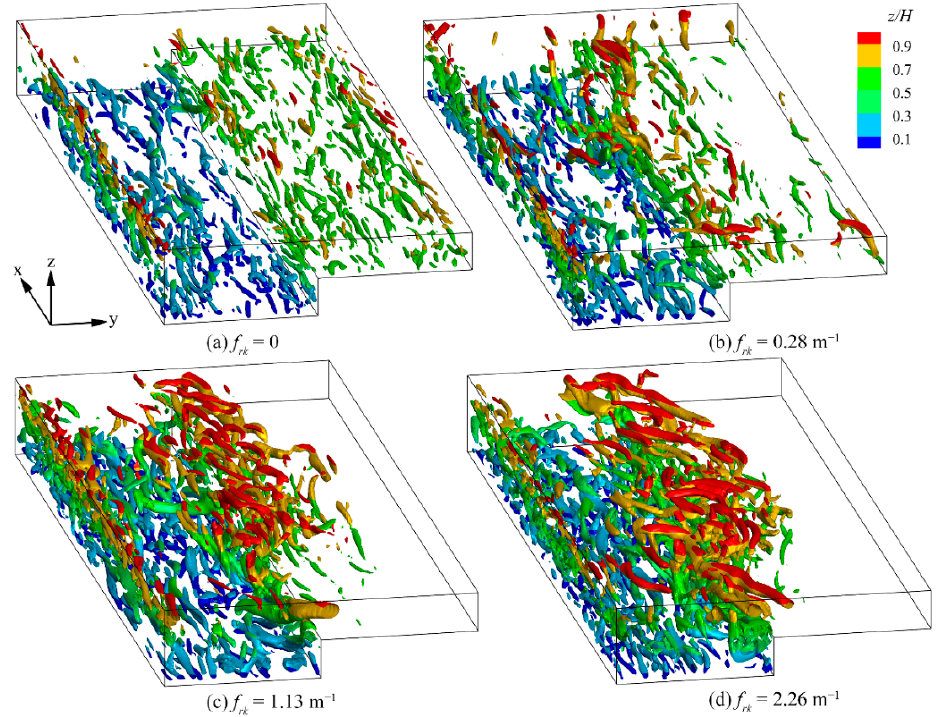
Figure 12. Instantaneous turbulent structure with different floodplain vegetation densities. ( a ) Case with f rk = 0. ( b ) Case with f rk = 0.28 m − 1 . ( c ) Case with f rk = 1.13 m − 1 . ( d ) Case with f rk = 2.26 m − 1